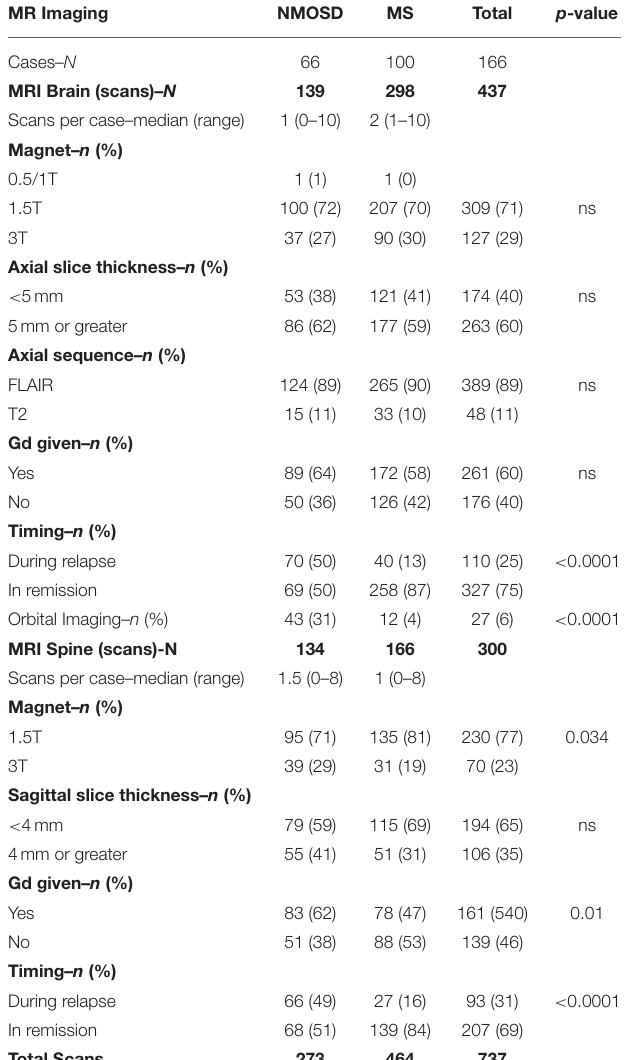
TABLE 3 | Total numbers and types of MRI reviewed.